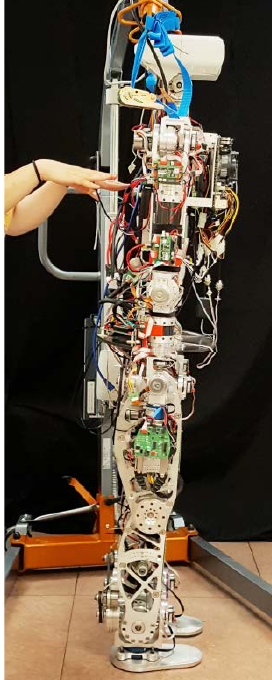
Figure 8. Experiment on applying force to the TEO